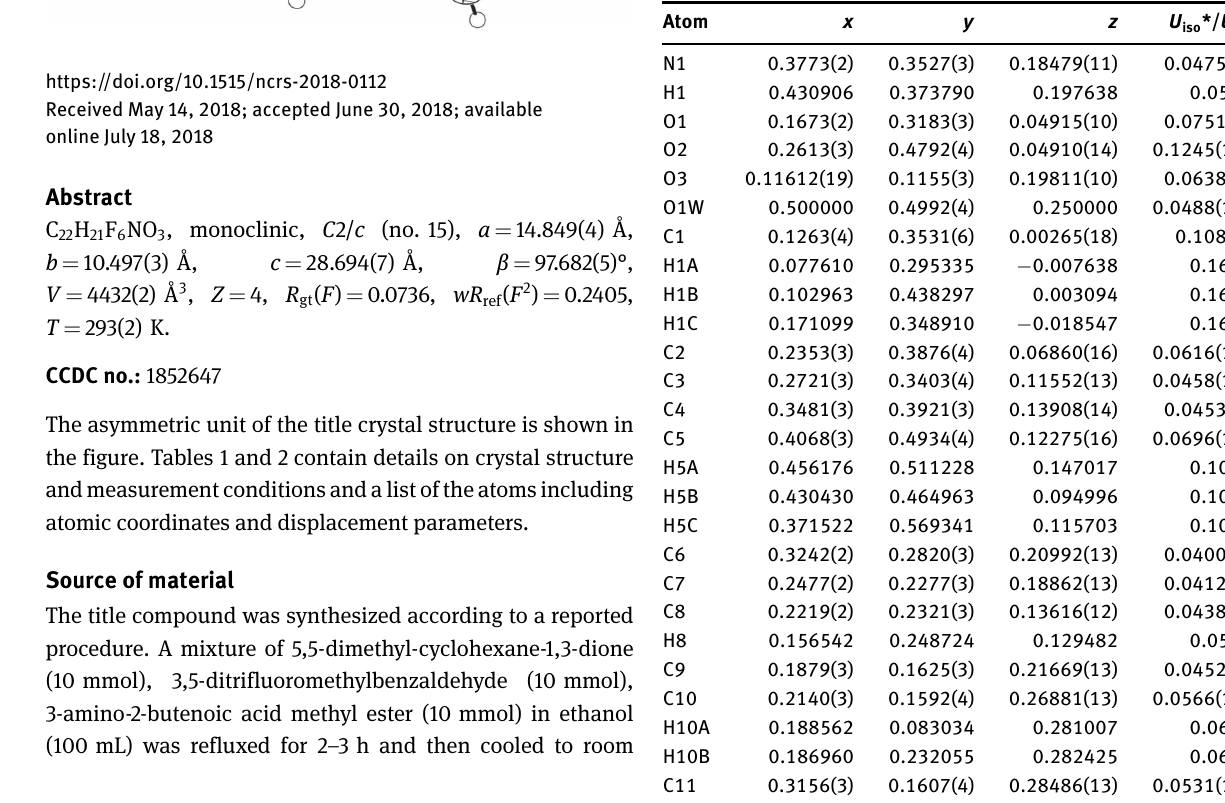
Table 2: Fractional atomic coordinates and isotropic or equivalent isotropic displacement parameters (Å 2